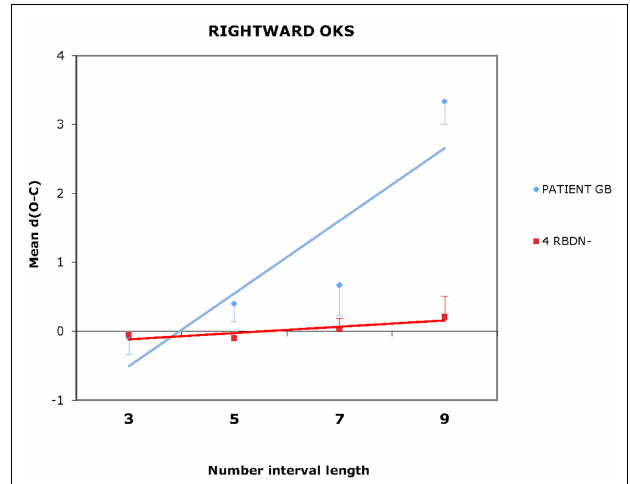
FIGURE 3 | In the rightward OKS condition, BG misbisected to the right of the true midpoint, as a function of number interval length. Even for length 9 the mean dO–C of RBDN – did not differ from 0, t (3) = 1.414, p = 0.252.